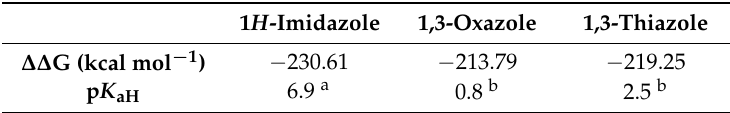
Table 3. Theoretically obtained free energy differences between protonated and deprotonated forms of heterocyclic compounds and their respective experimental p K aH values.